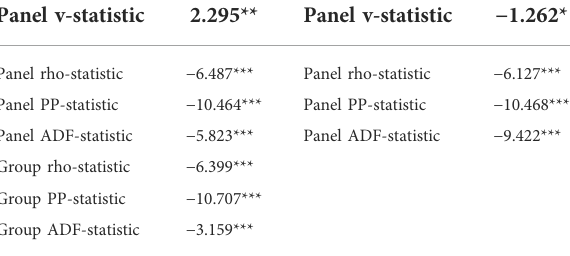
TABLE 3 Results of Padrones ’ panel cointegration test.